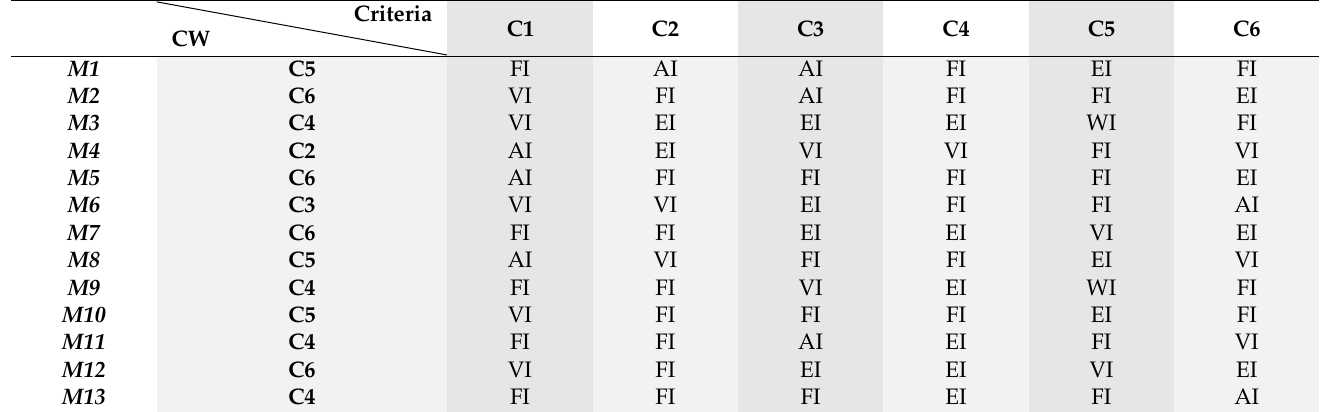
Table 5. Comparison of the other criteria to the